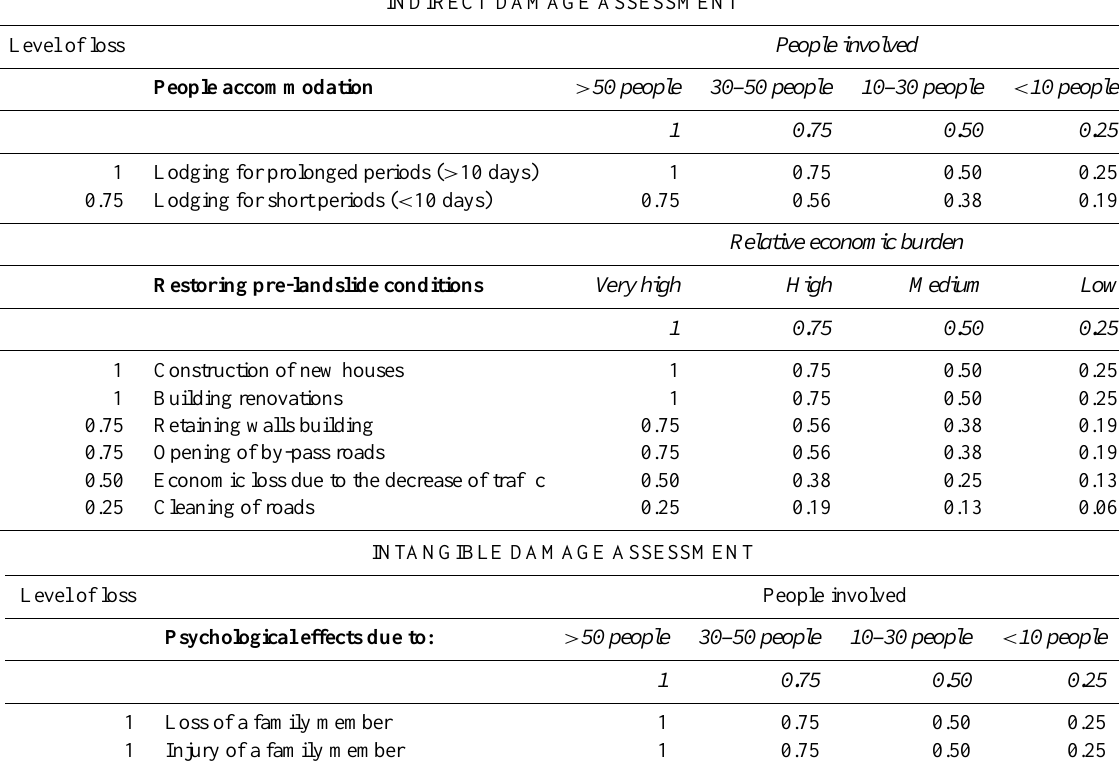
Table 2. Forms to fill out to assess indirect and intangible